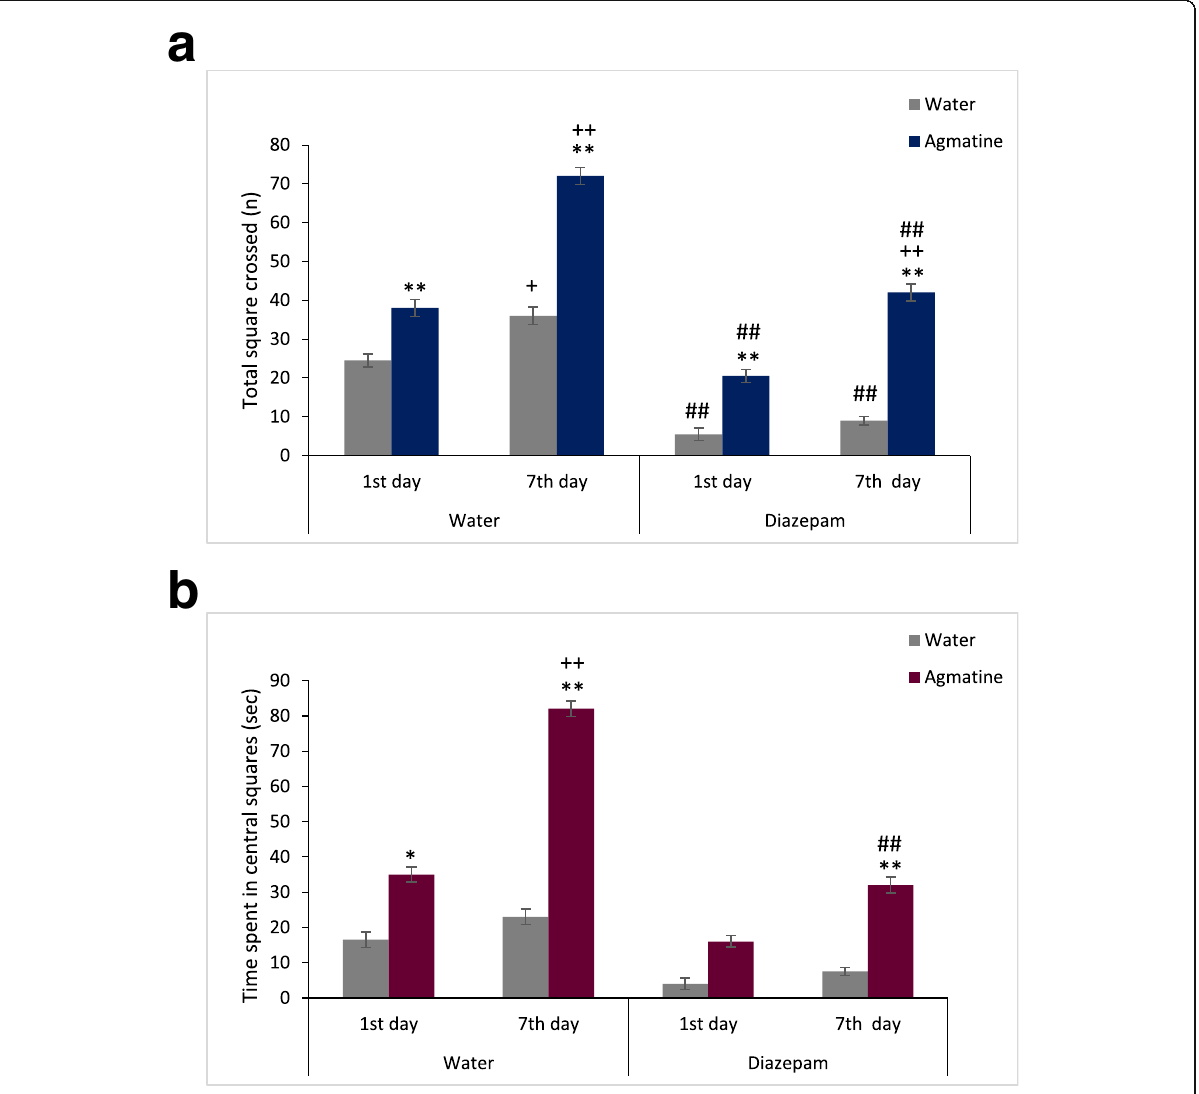
Fig. 2 a Open field test (total square crossed): Values are expressed as means ± SD (n = 12). Significant differences by Newman-Keuls test: ** p < 0.01, * p < 0.05 from control group to agmatine-treated groups. ++ p < 0.01, + p <0.05 from the 1st day administration of water and agmatine. ## p < 0.01, # p < 0.05 from water-pretreated animals to respective withdrawal animals following II-way ANOVA. b Open field test (time spent in central squares): Values are expressed as means ± SD (n = 12). Significant differences by Newman-Keuls test: ** p < 0.01, * p < 0.05 from control group to agmatine- treated groups. ++ p < 0.01, + p < 0.05 from the 1st day administration of water and agmatine. ## p < 0.01, # p < 0.05 from water-pretreated animals